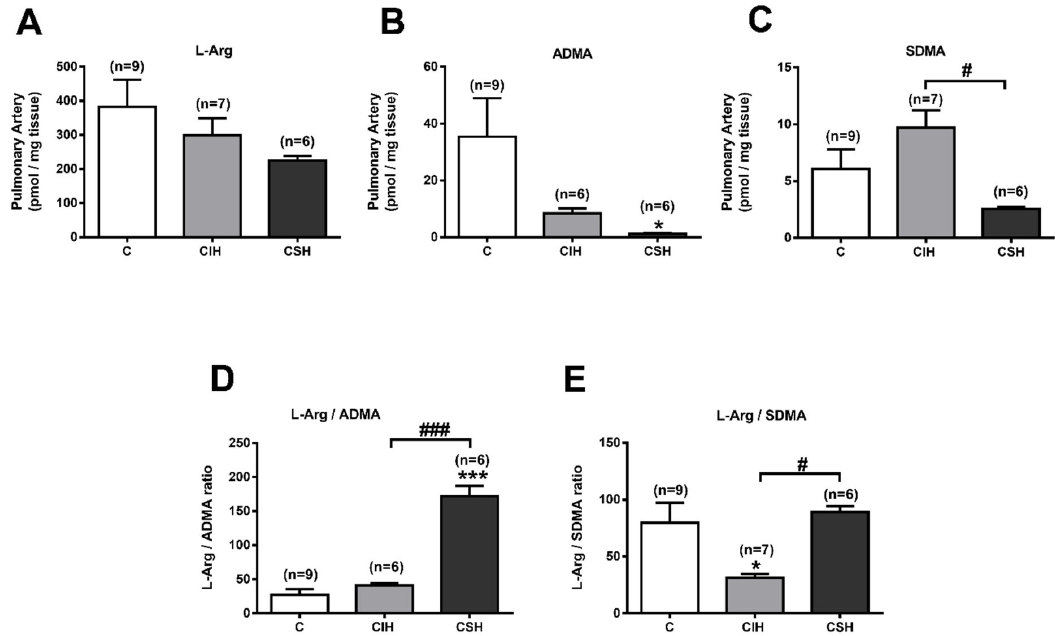
Figure 6. L-Arginine and arginine-methylated metabolites in pulmonary arteries (PA). ( A ) PA levels of L-Arginine (pmol/mg tissue). ( B ) PA levels of ADMA (pmol/mg tissue). ( C ) PA levels of SDMA (pmol/mg protein) measured by HPLC-FD. ( D ) Ratio L-Arginine/ADMA. ( E ) Ratio L-Arginine/SDMA, in C, CIH, and CSH animals. Data are expressed as mean ± SEM ( n = 6–9 rats). * p < 0.05, *** p < 0.001 vs. C one-way ANOVA with Dunnet post-test; # p < 0.05, ### p < 0.001 vs. CIH unpaired t ‐ test.